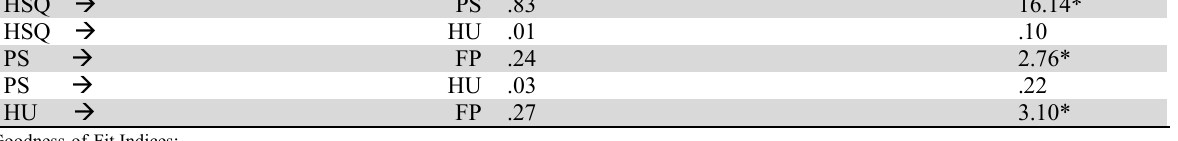
Standardized Parameter Estimates and Goodness-of-Fit Indices Path Parameter